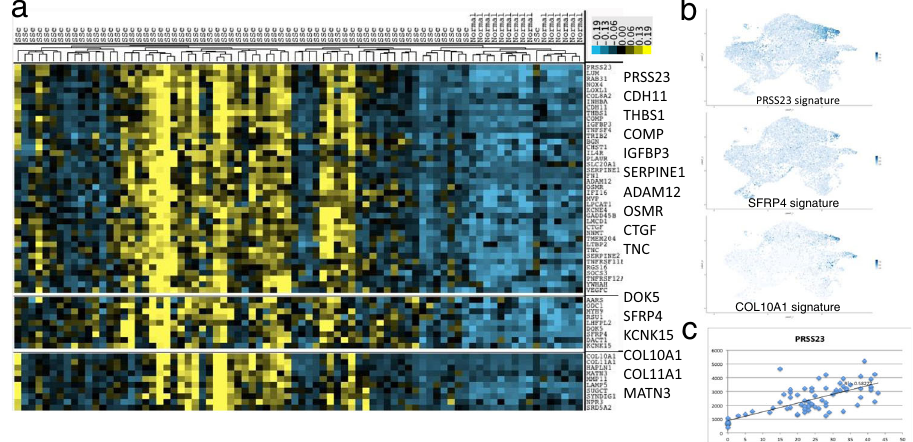
Fig. 7 Bulk RNA expression data clusters re fl ect gene expression by SSc fi broblasts and myo fi broblasts. Bulk gene expression from microarrays of patients with SSc ( n = 66) and healthy control skin ( n = 9) was clustered hierarchically ( a ; yellow = high, blue = low expression). Feature plots corresponding to gene expression signature in of each microarray cluster are shown ( b , Seurat AddModuleScore function). The correlation of PRSS23 with the MRSS is shown ( c